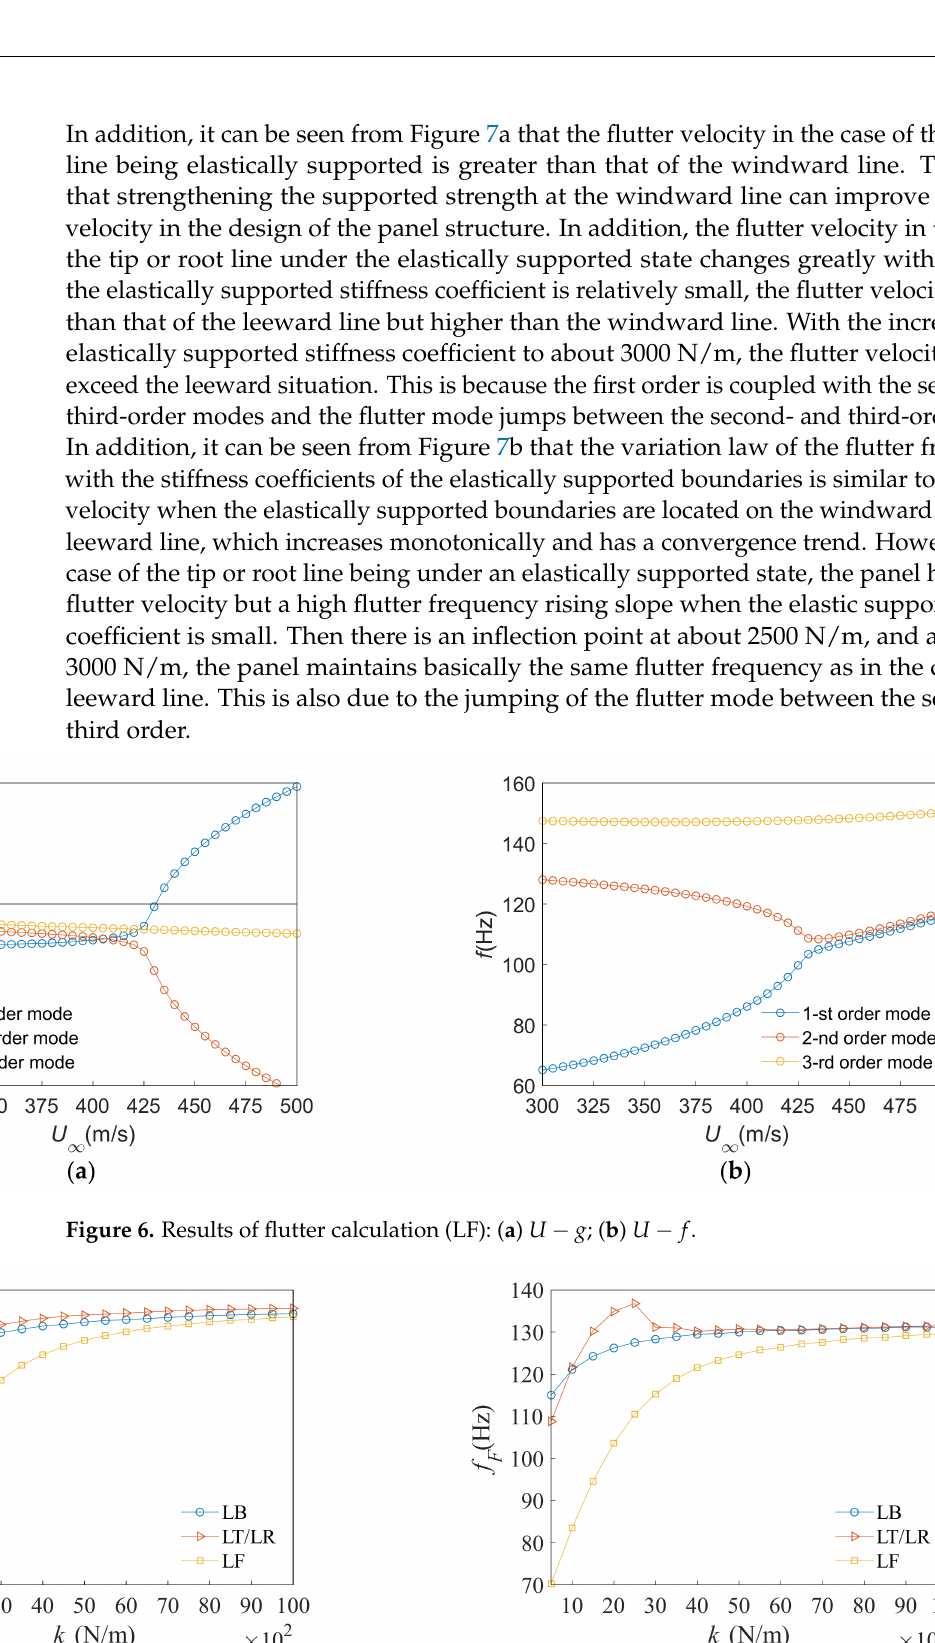
Figure 7. Flutter velocities and frequencies versus stiffness of the elastically supported boundaries: ( a ) U F versus k c ; ( b ) f F versus k c